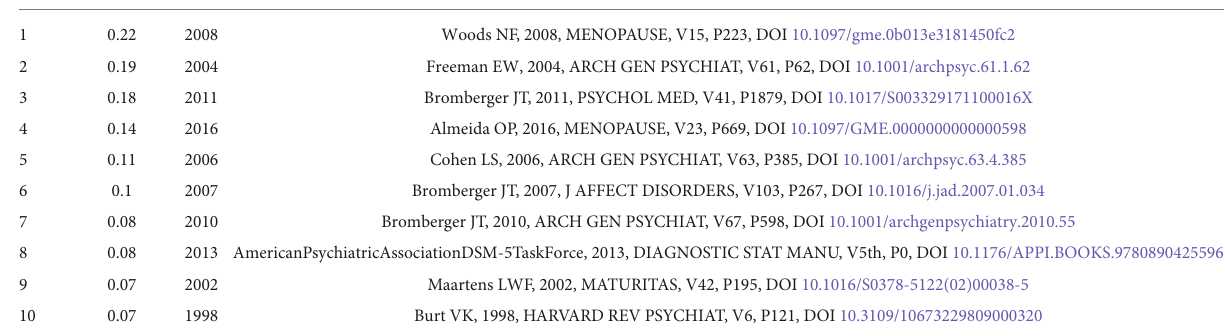
TABLE 6 Top 10 co-cited references related to PMD in Centrality. Rank Centrality Years